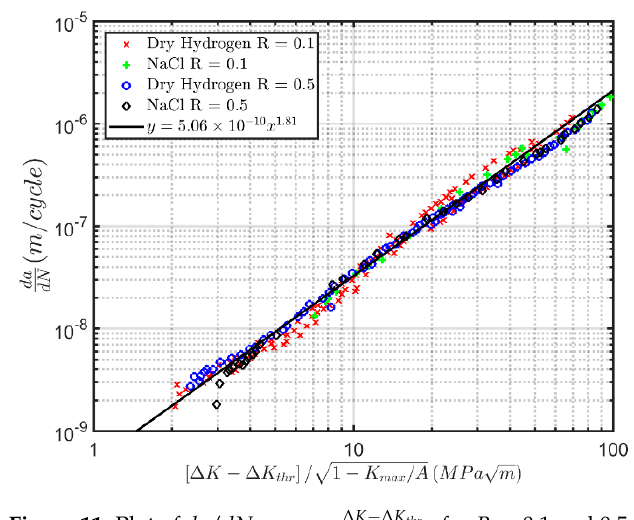
∆ K − ∆ K for (cid:1844) = 0.1 and 0.5. thr √ for R = 0.1 and 0.5. (cid:3493)(cid:2869) (cid:2879) (cid:3012) (cid:3288)(cid:3276)(cid:3299) /(cid:3002) 1 − K max / A